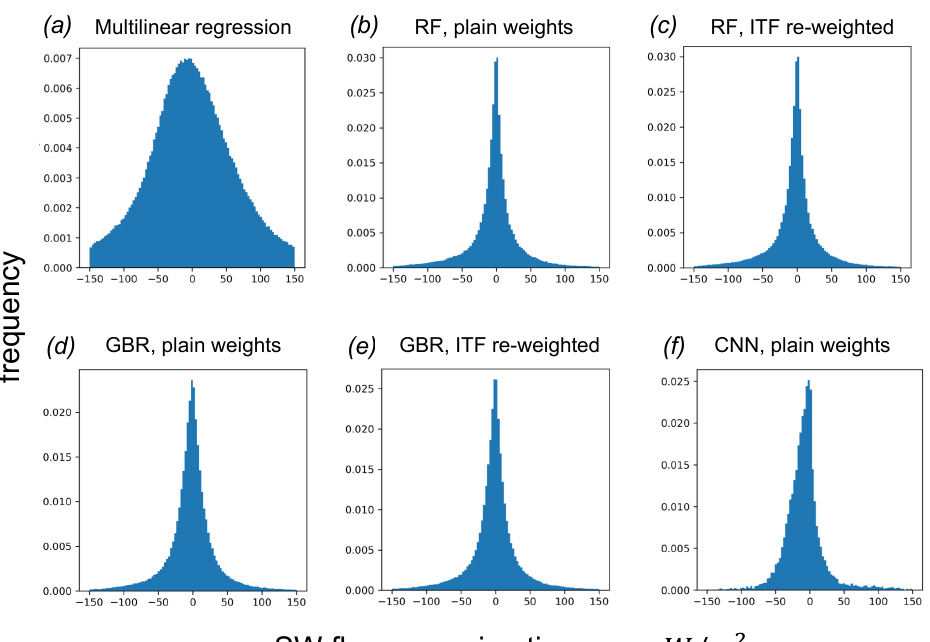
Figure 7. Error histograms for: ( a ) Multilinear Regression as a baseline; ( b ) Random Forests without ITF re-weighting; ( c ) Random Forests using ITF re-weighting of the train subset; ( d ) Gradient Boosting for Regression without ITF re-weighting; ( e ) Gradient Boosting for Regression using ITF re-weighting of train subset; ( f ) convolutional neural network (no re-weighting).